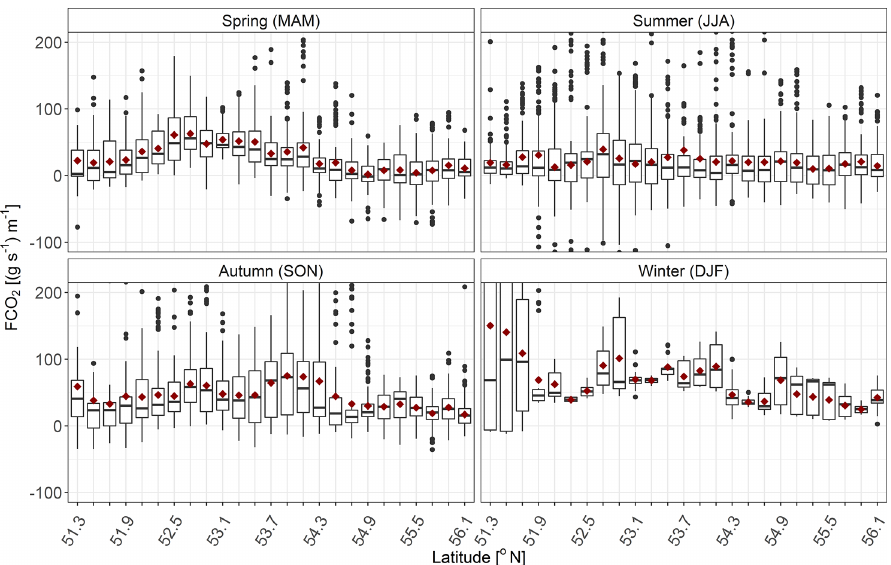
Figure 8. Box and whisker plots of 5min binned averages of CO 2 fluxes along the route of the ferry (latitude bin width: 0.2 ◦ ). The horizontal bar within each box corresponds to the median for a given latitude bin, the upper and lower hinges represent the 75th and 25th quantiles, respectively, and the upper and lower whiskers indicate the largest–smallest observation less–greater than or equal to upper–lower hinge ± 1 . 5 ∗ IQR (inter-quantile range), respectively. The outliers are represented by solid circles and arithmetic means by red diamonds. The flux is integrated over the height of the planetary boundary layer and expressed in units of mass flux per metre travelled crosswind within each latitude bin per unit